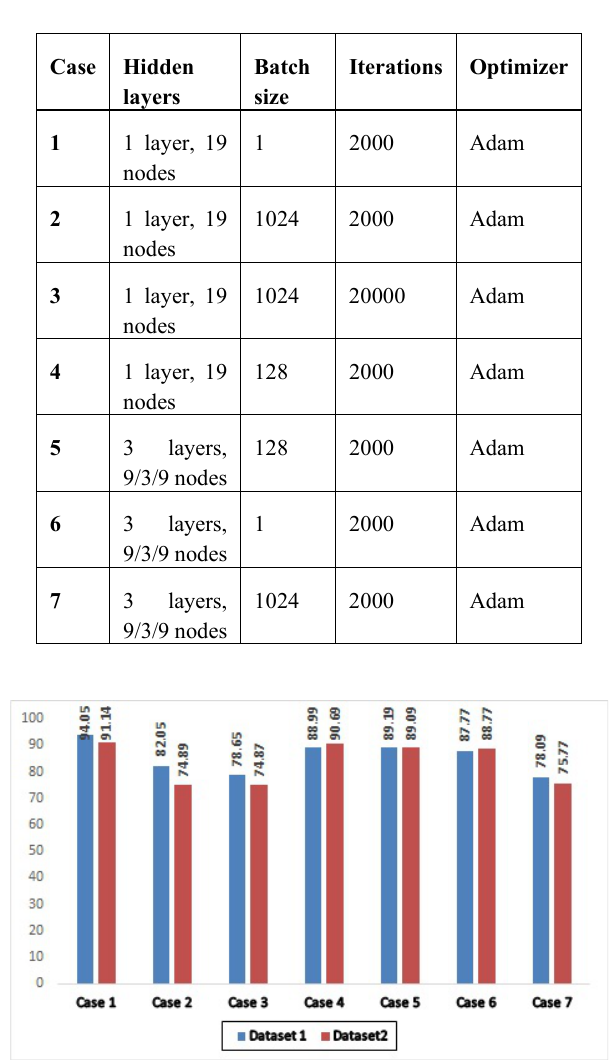
Figure 2. Accuracy graph for autoencoder based classification in